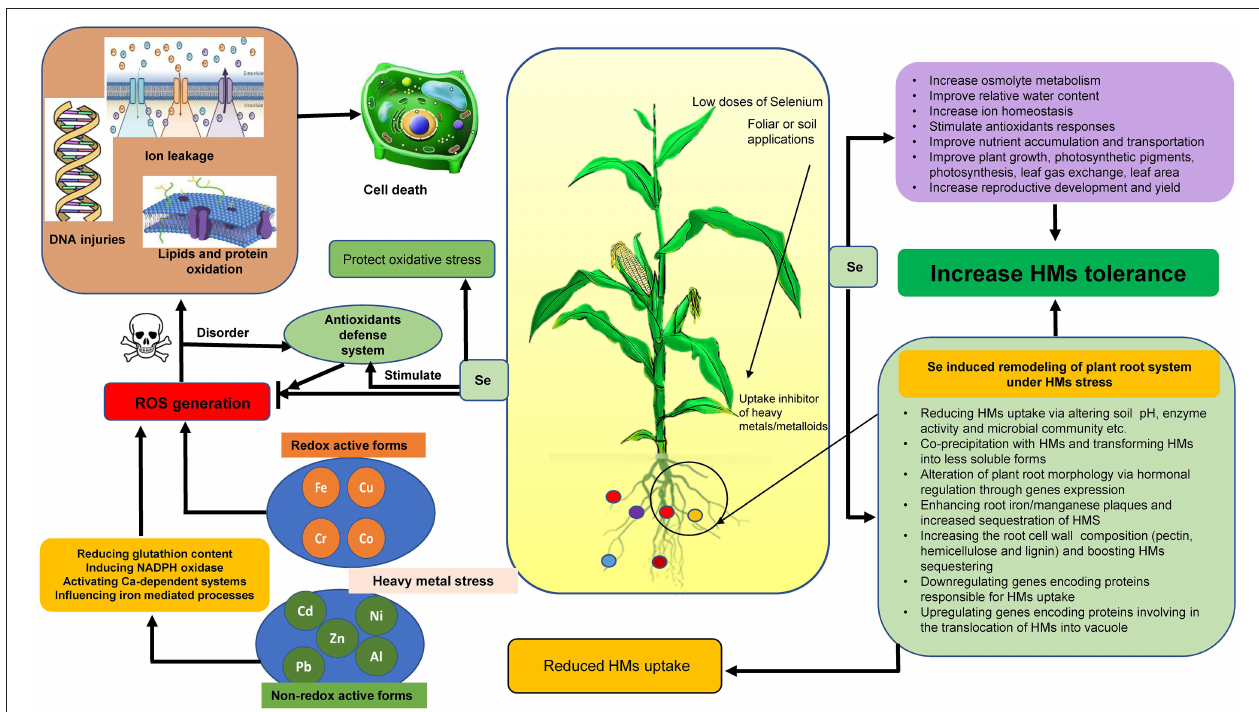
FIGURE 1 | ROS generation under heavy metal stress and protective roles of